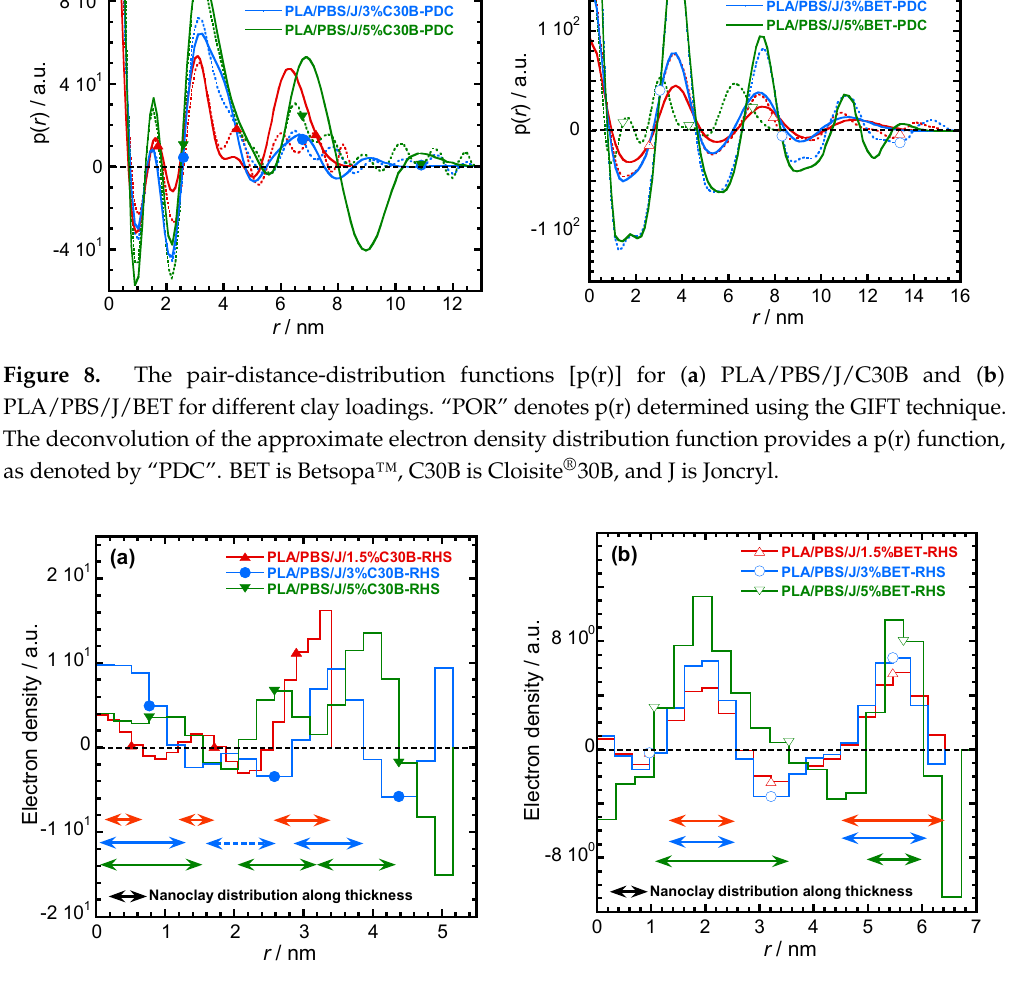
Figure 9. Electron density profiles for ( a ) PLA/PBS/J/C30B and ( b ) PLA/PBS/J/BET, for different clay loadings. BET is Betsopa™, C30B is Cloisite ® 30B, and J is Joncryl.